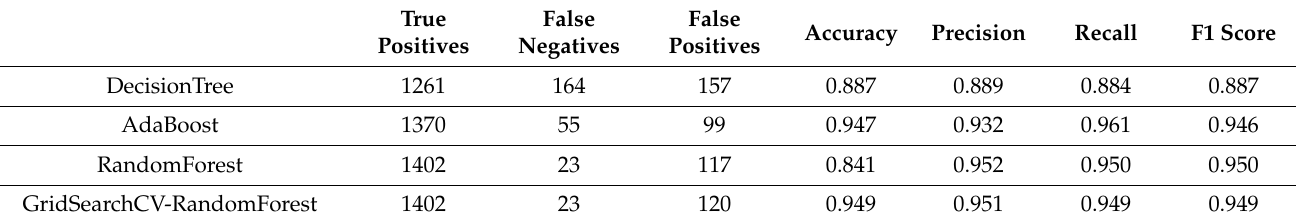
Table 5. FreezerRegularTrain dataset.